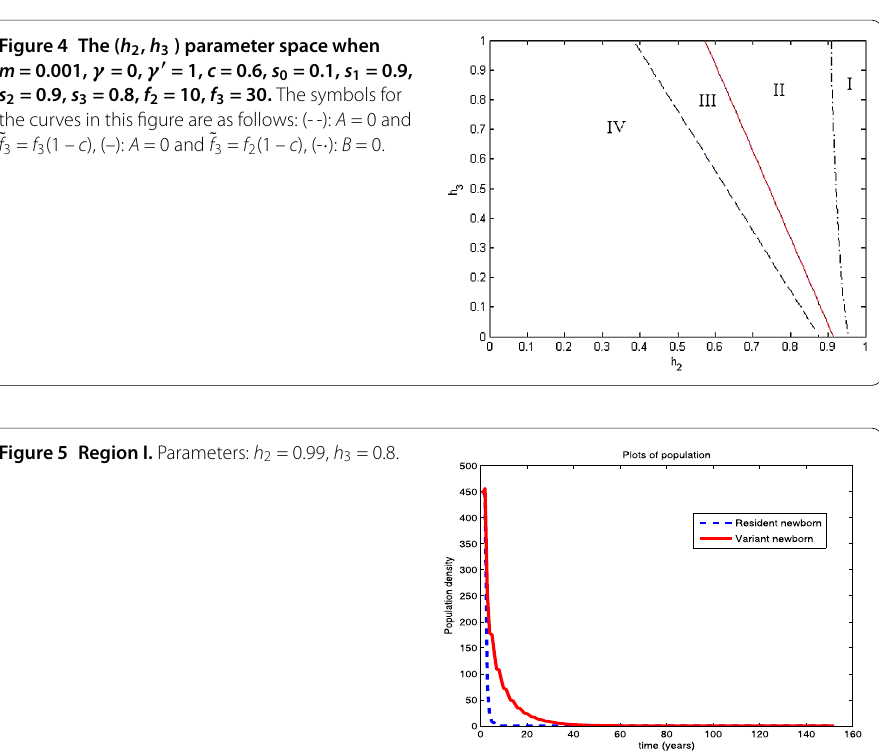
Figure 5 Region I. Parameters: h 2 = 0.99, h 3 =